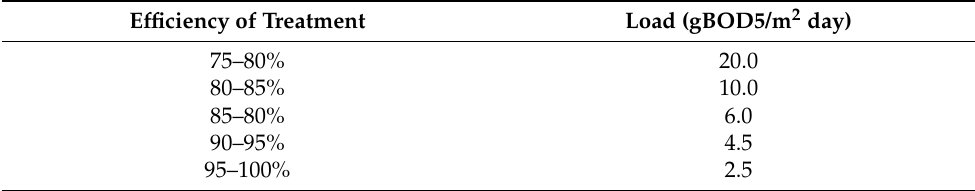
Table 2. Efficiency of MBBR depending on water load with